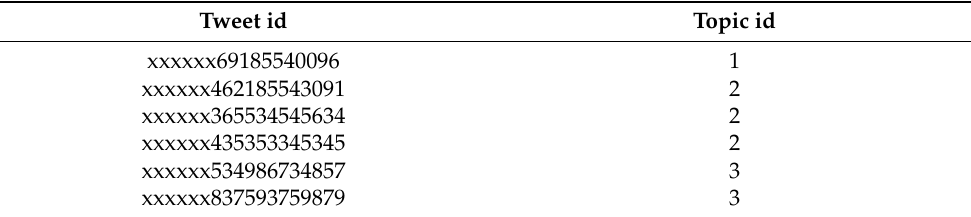
Table 1. Dataset